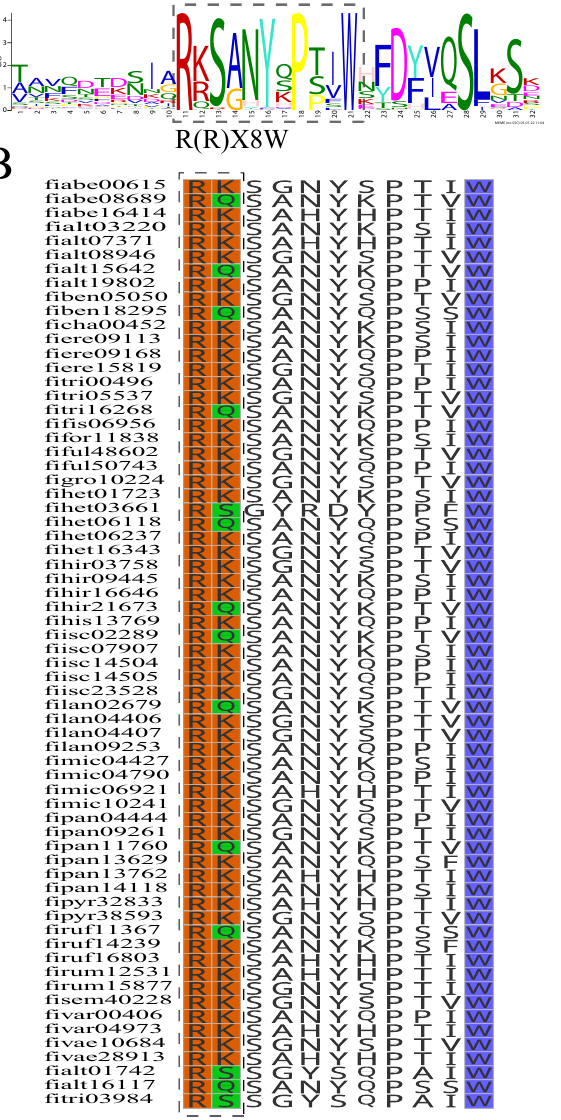
Figure 2. The R(R)X8W motif of the FTPS genes in the TPS-b subfamily. ( A ) The R(R)X8W motif logo of all FTPS-b subfamily genes. ( B ) Some representative sequences of FTPS-b subfamily genes, showing the R(R)X8W motif without the tandem RR